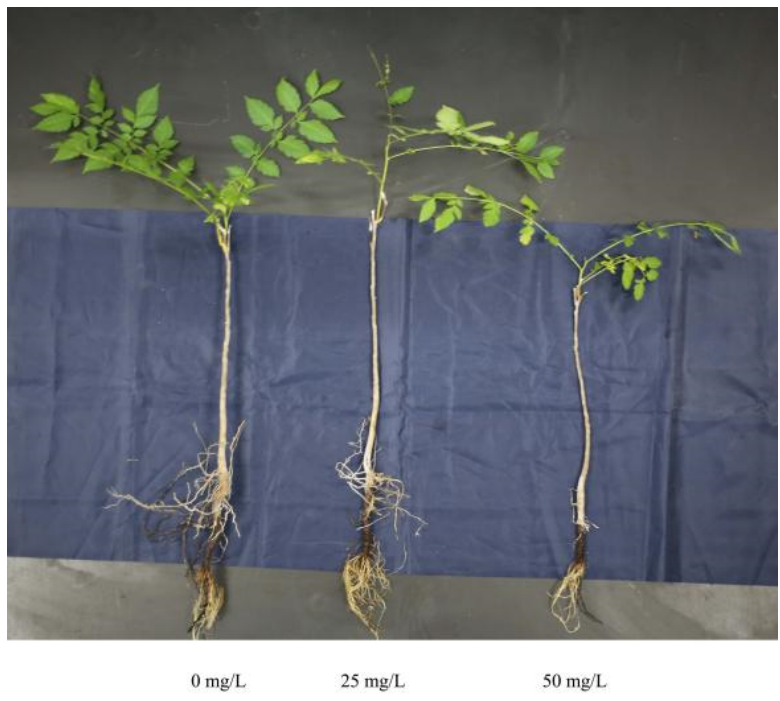
Figure 1. Phenotypes of the goldenrain tree Koelreuteria paniculata after cadmium treatment.